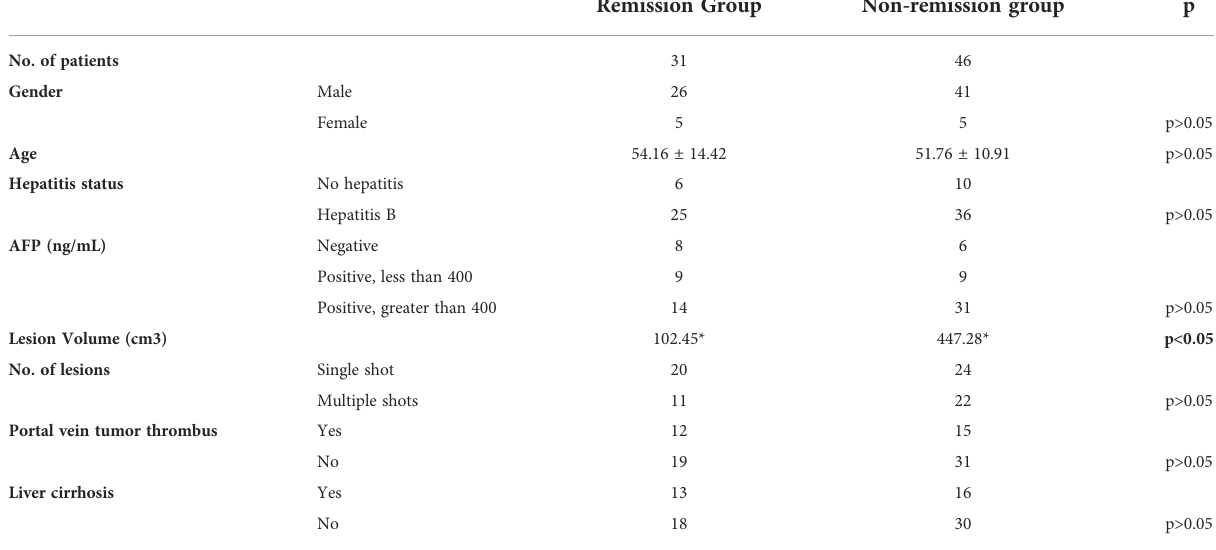
TABLE 1 Comparison of the general characteristics between two groups before TACE